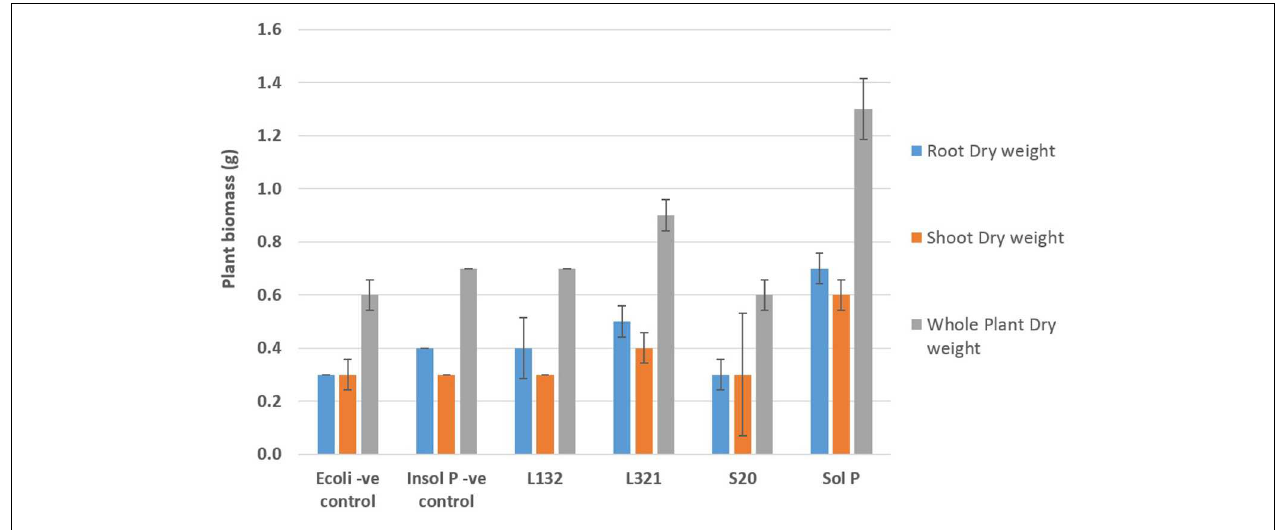
FIGURE 1 | Biomass (dry weight) of P. sativum L. plants inoculated with bacterial endophytic strains capable of solubilizing inorganic phosphate (Ca 3 (PO 4 ) 2 ) after 60 days of cultivation under greenhouse conditions. Insol P, Insoluble